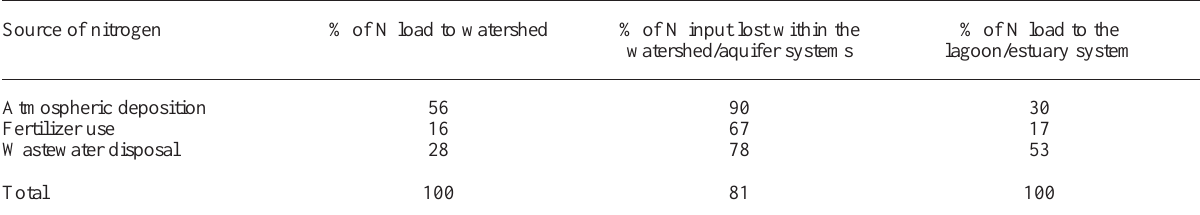
) was T was greater T